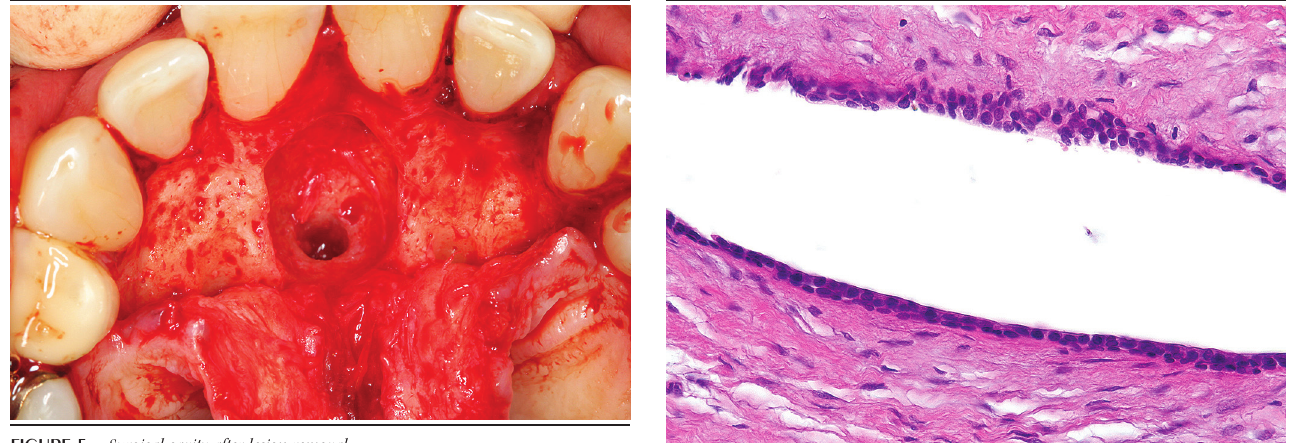
figurE 5 − Surgical cavity after lesion removal